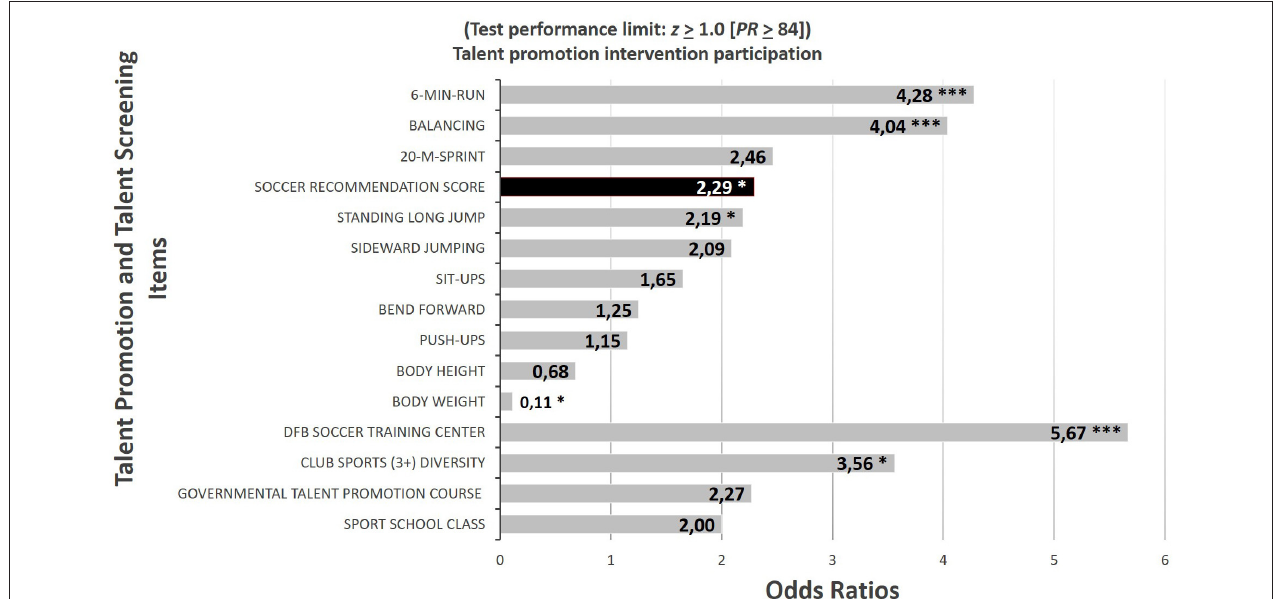
FIGURE 6 | Odds ratios (at the z = 1.0 and PR = 84 threshold) of the two body dimensions and eight generic motor tests and the soccer recommendation score, as well as of four talent promotion interventions to predict the relative chances of the U9 participants to reach the highest (province) level of soccer competition performance at adolescent age (U17). Significant results are marked by asterisks: * p < 0.05; *** p < 0.001.